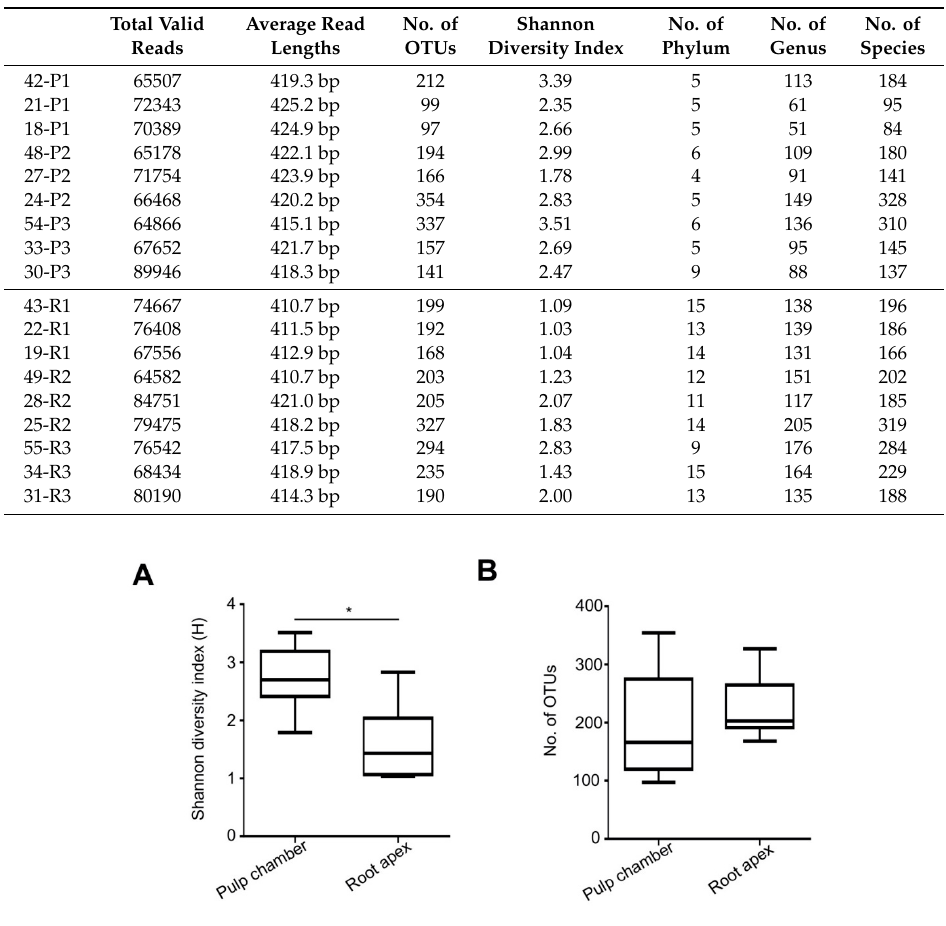
Table 1. Summary of pyrosequencing.